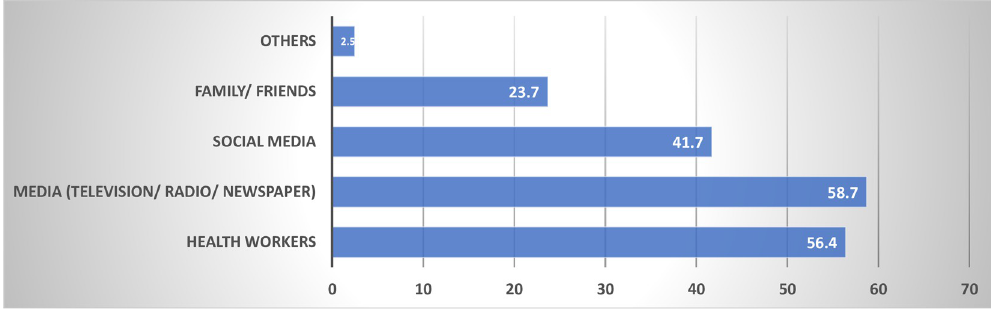
Fig 1. Respondents’ sources of information of first phase COVID-19 vaccination exercise in Nigeria. Individual responses may have multiple sources of information. The total sources of COVID-19 vaccination information are not equal to the total or